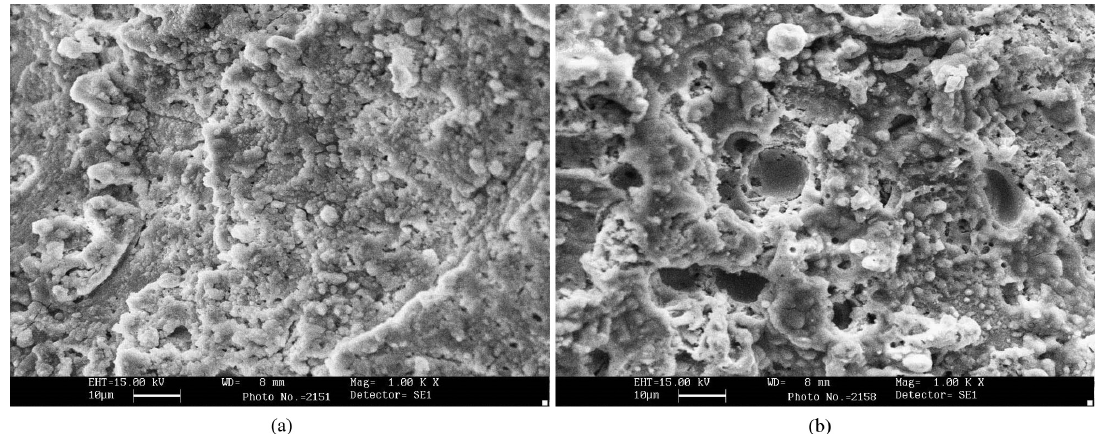
Figure 12. SEM image of fracture surface for impact test of the specimens: (a) Al